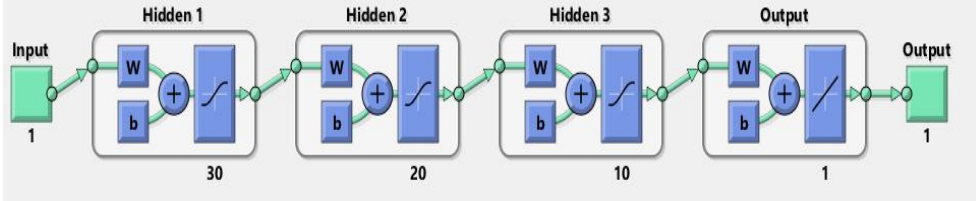
Figure 7. Sample neural network used for